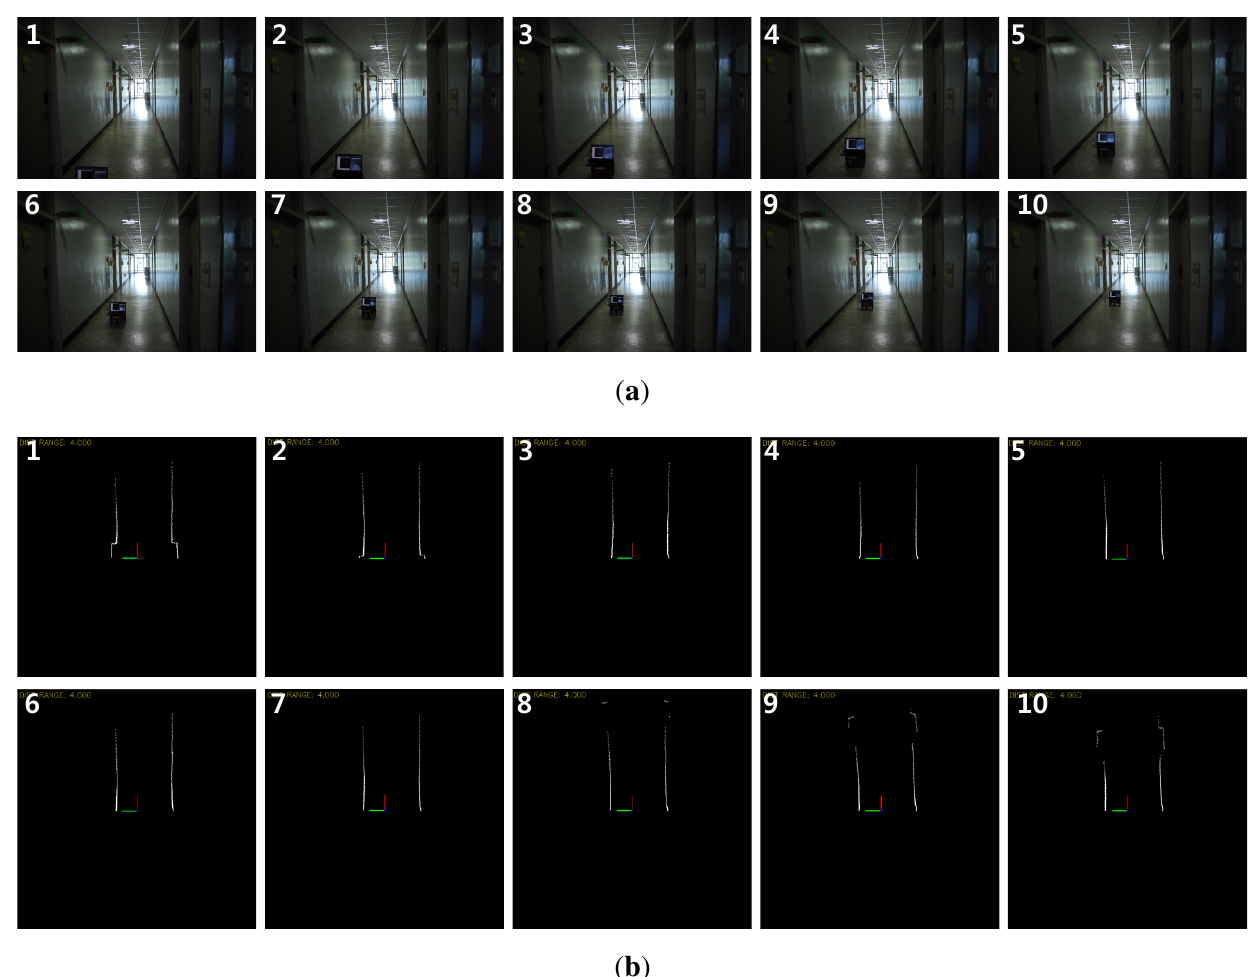
Figure 12. Scene examples of the laser scan ambiguity. From the third to seventh scenes, the ambiguity occurs because the laser scanner measures only straight wall components. each robot